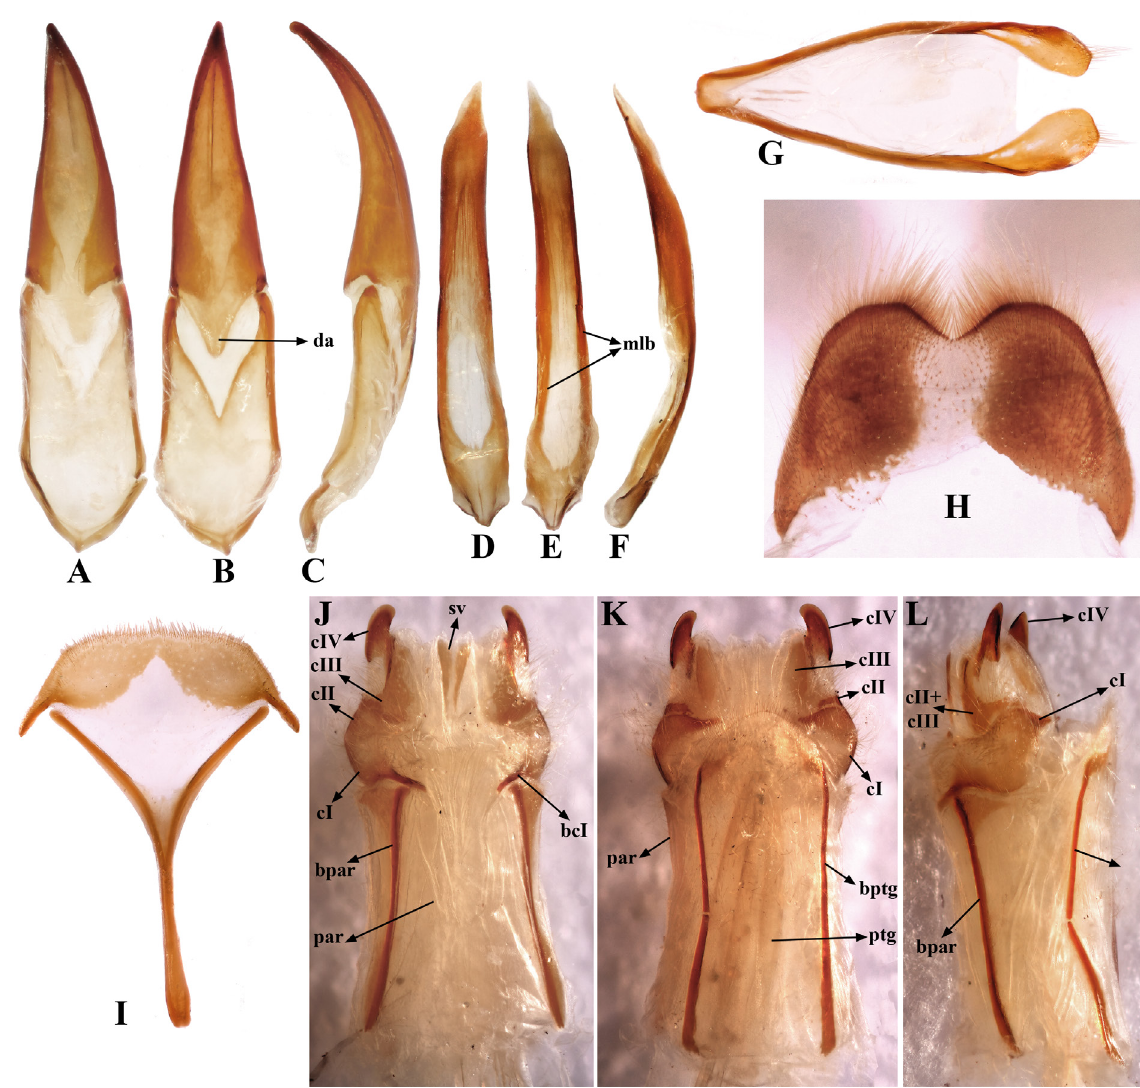
Fig. 18. Przewalskia dilatata (Reitter, 1887), genitalia (ZIN). A . Tegmen of aedeagus, ventrally. B . Ditto, dorsally. C . Ditto, laterally. D . Median lobe, ventrally. E . Ditto, dorsally. F . Ditto, laterally. G . Spiculum gastrale. H . ♂, inner sternite VIII. I . ♀, inner sternite VIII and spiculum ventrale. J . Ovipositor, ventrally. K . Ditto, dorsally. L . Ditto, laterally. Not to scale. Abbreviations: see Material and